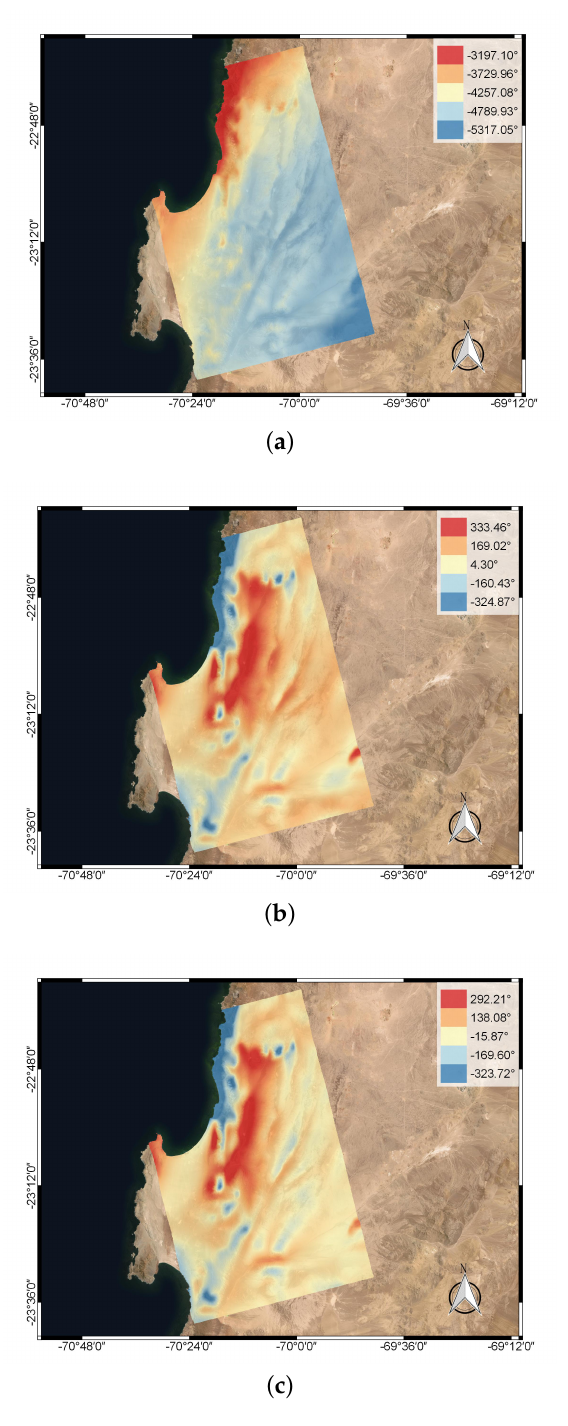
Figure 12. Ionospheric correction with height error by SSM on 20080131 and 20080317: ( a ) Ionospheric phase delay. ( b ) Corrected DInSAR phase. ( c ) Corrected DInSAR phase